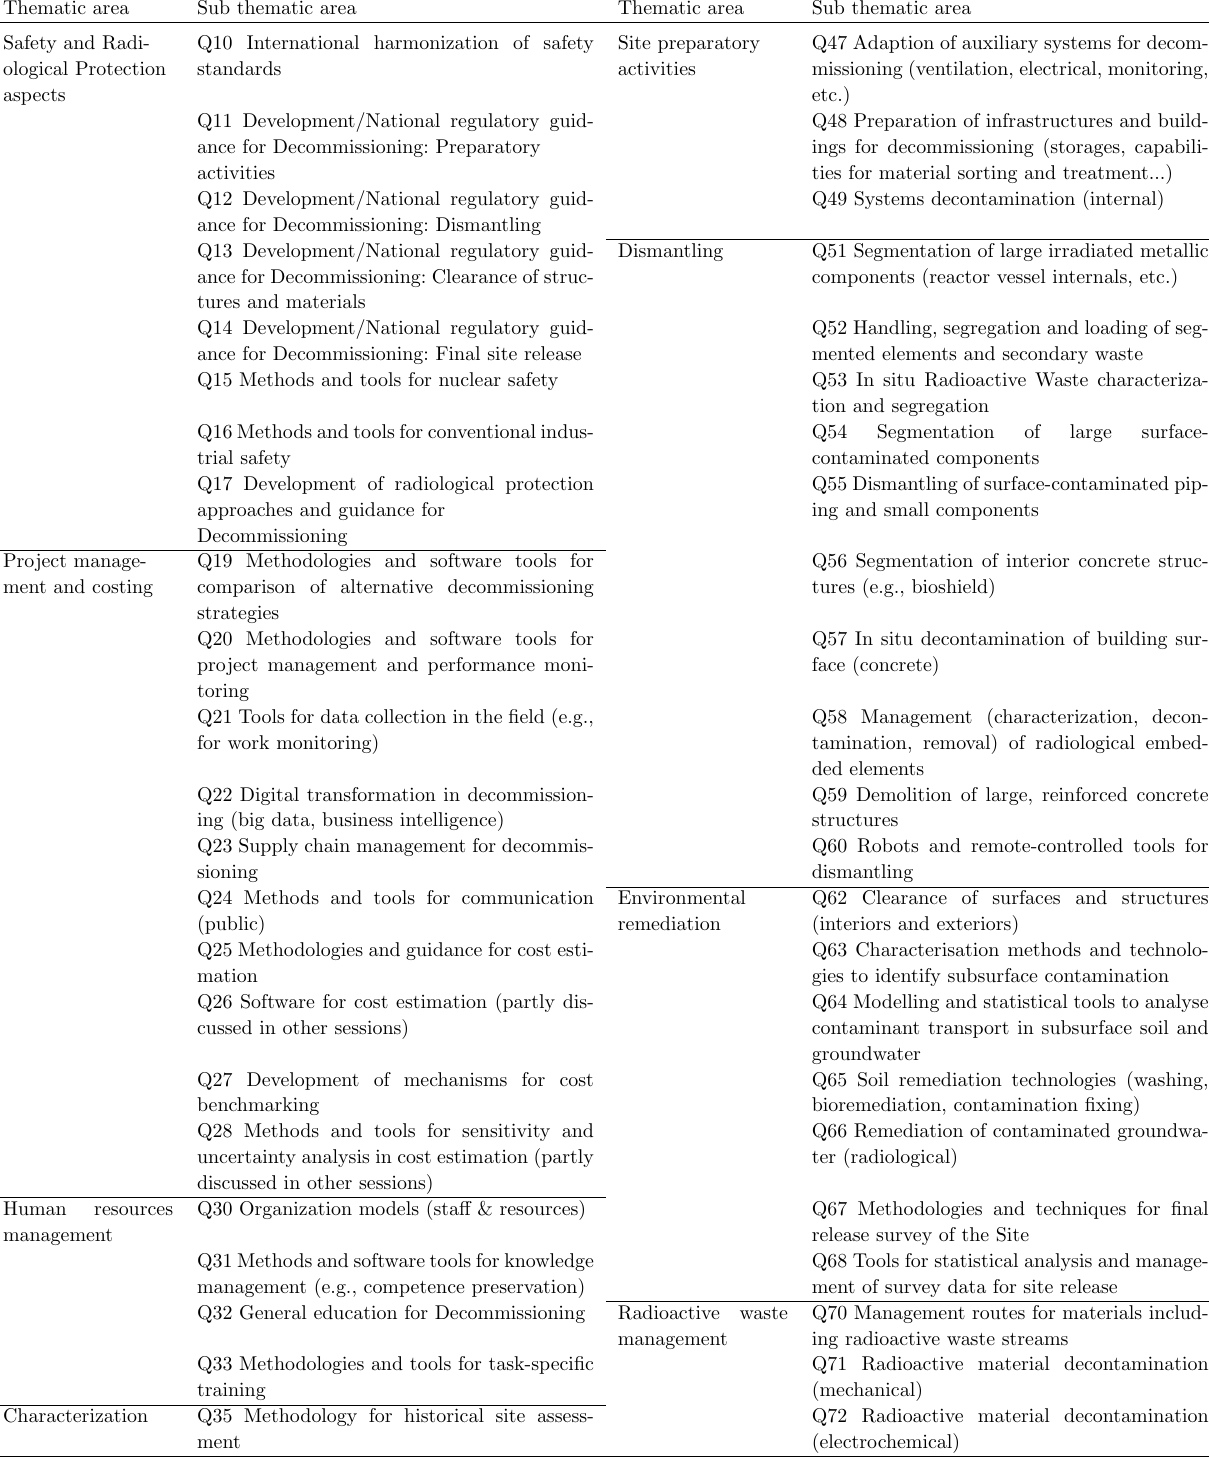
Table A.1. List of thematic and sub-thematic areas in the questionnaire